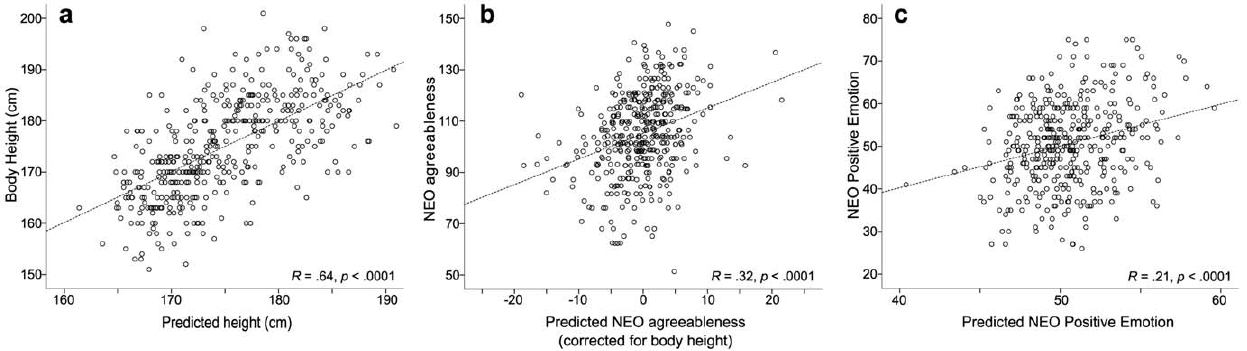
Figure 3. Stepswise regressions. ( a ) Result of the stepwise regression with body height as dependent variable, and ECG amplitude values as independent (predictor) variables. ( b ) shows the result of the stepwise regression (corrected for body height) with agreeableness as dependent variable, and ECG amplitude values, as well as body height, body weight, and body mass index as independent variables. The analogous regression for positive emotion is shown in ( c ). doi:10.1371/journal.pone.0031441.g003 PLoS ONE |